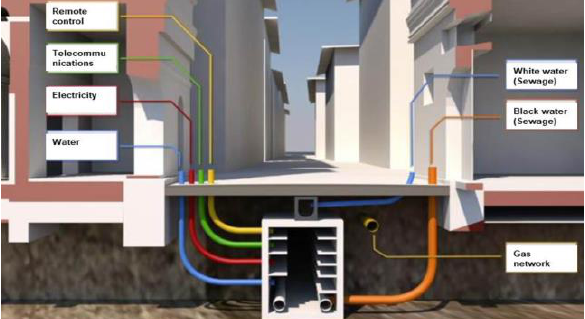
Figure 4. The first excerpt or "Central axis" is in gray; the five lots that represent the second part are identified with the